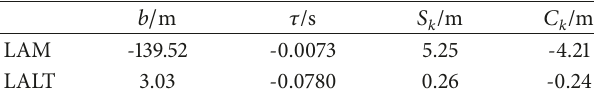
Figure 4: Differences of DEMs compared to LOLA DEM. (a) model from original LAM data, (b) model from LAM data with orbit improvement, and (c) model from LAM data with calibration. Table 2: Results of LAM and LALT data